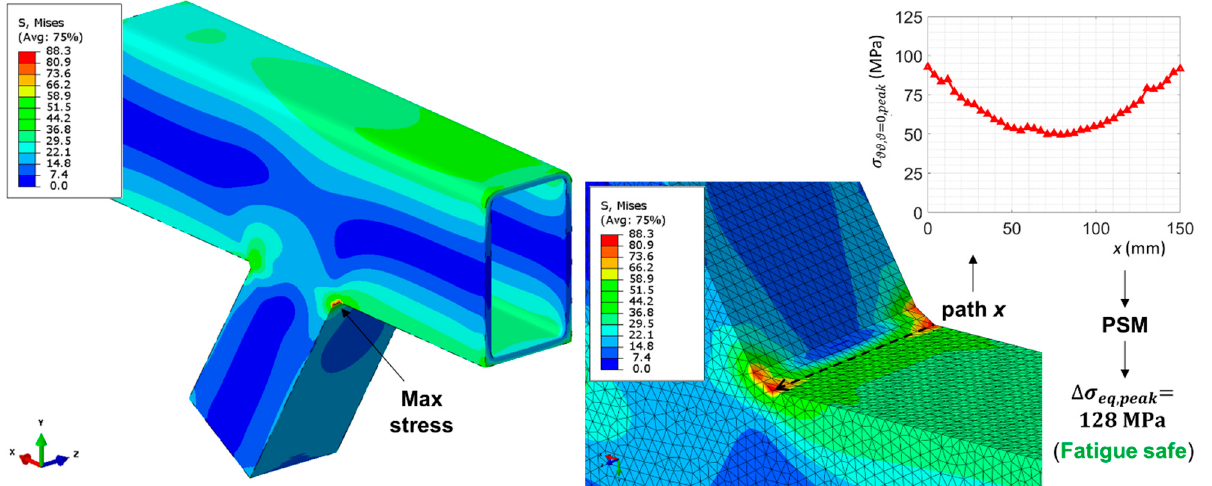
Figure 6. Contour plot of 3D von Mises stress in the most critical position; extraction of σ ϑϑ , ϑ = 0, peak along the path for the application of the PSM to predict the fatigue life of the weldment; units in MPa.